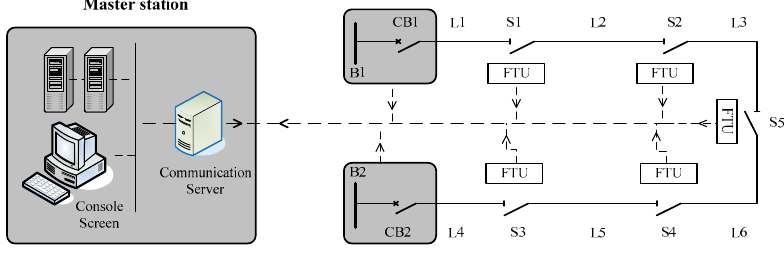
Figure 1. An integrated DFA system.